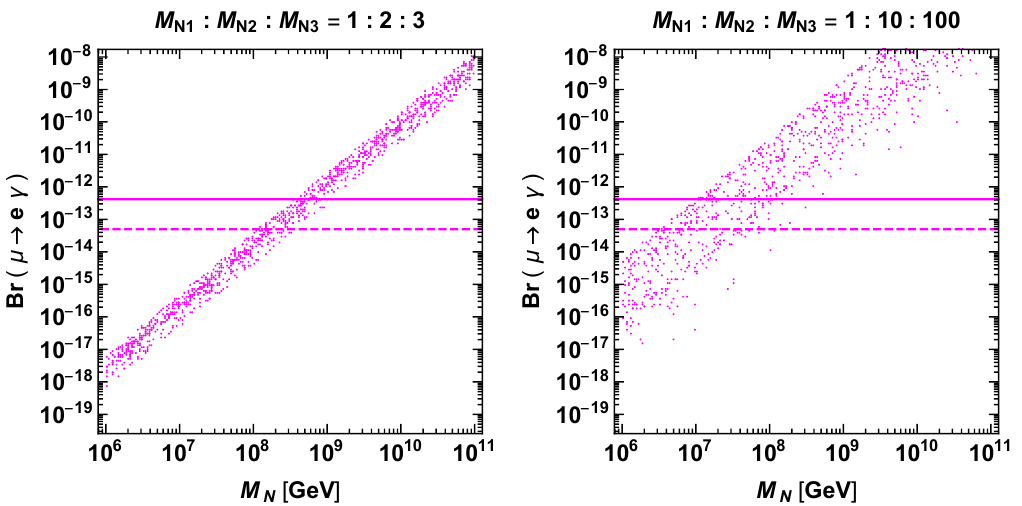
: M N : M N = 1 : 1 2 3 = m 2 = − 4 × 10 8 GeV 2 H u H d